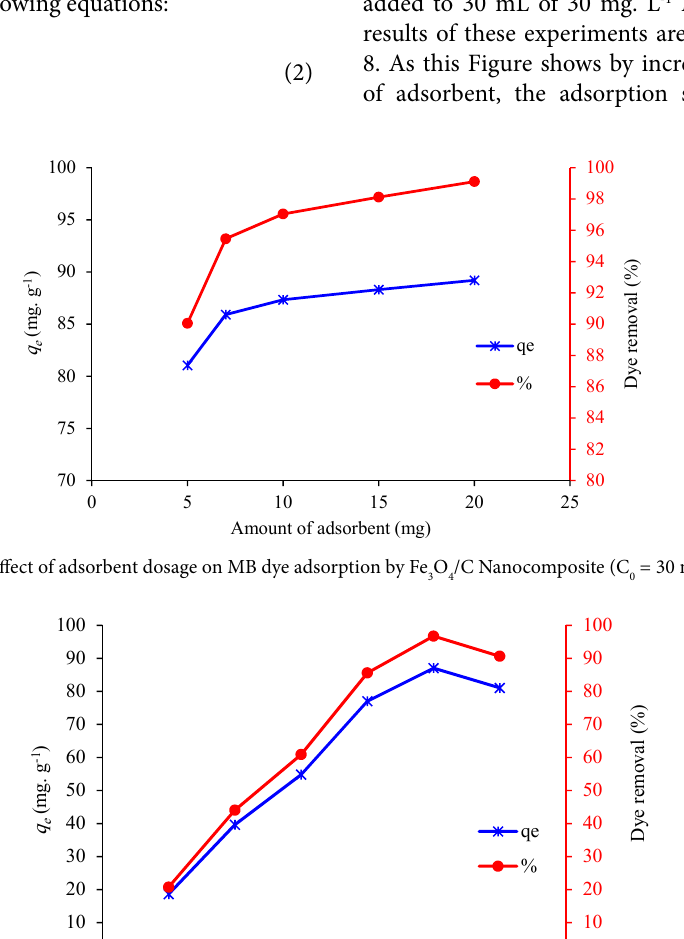
Fig. 9: Effect of initial pH on the adsorption capacities of nanoadsorbent (Fe O /C) for MB. (C = 30 mg. L -1 , solution volume = 30 3 4 0